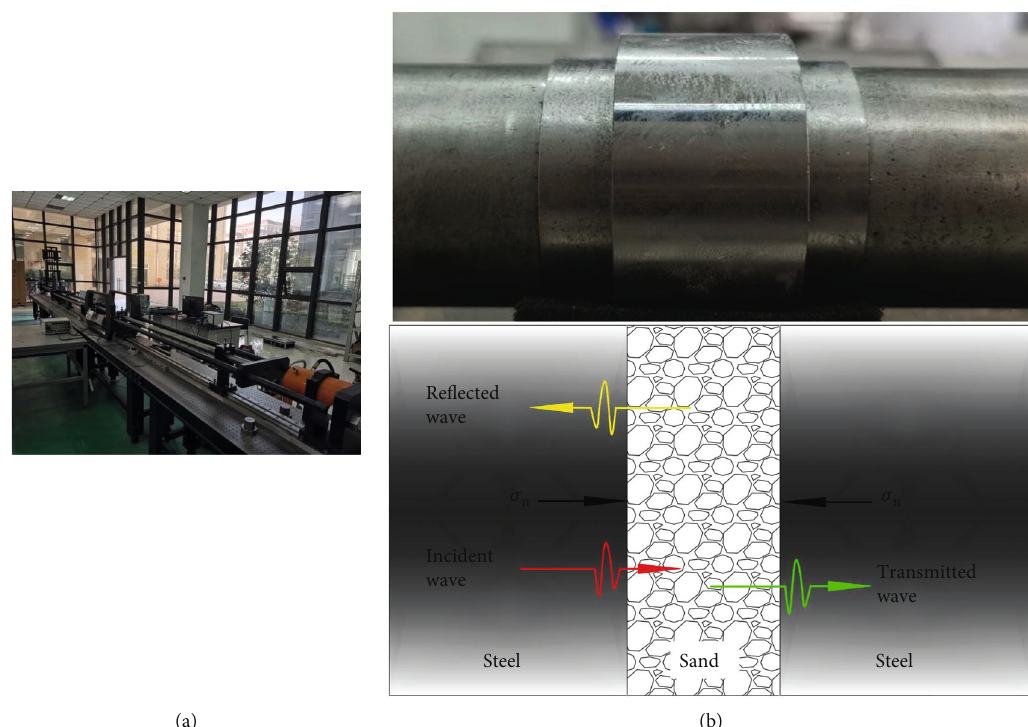
Figure 3: (a) Experimental setup. (b) Schematic of steel specimen con fi nement chamber and wave propagation in the